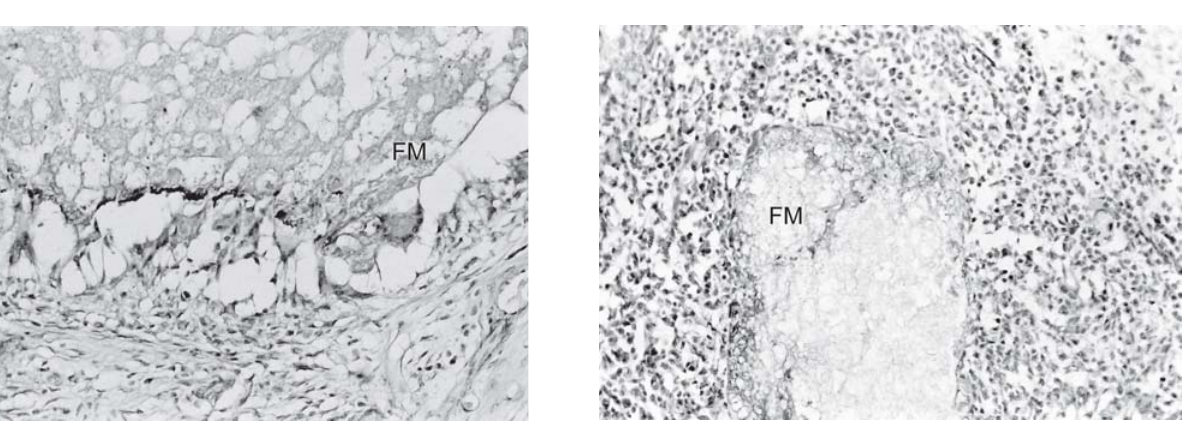
FIGURE 4 - Higher magnification of Figure 3. Neutrophils and chronic inflammatory cells are surrounding a particle of the filling material (FM). H.E. X 200